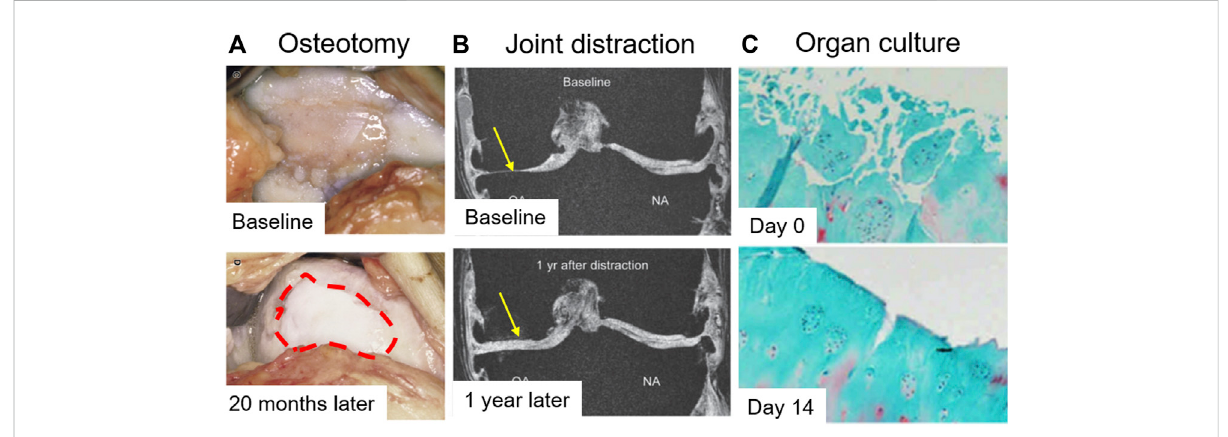
FIGURE 5 Evidence ofcartilagerebuilding in vitro and in vivo . (A) The articularsurfacewasobserved20 months after hightibialosteotomy(HTO).The red dotcircle shows neocartilageformation(Intema etal.,2011). (B) Quantitativemagnetic resonance imaging(MRI) ofthejointwastaken after 1 year of joint distraction (Koshino et al., 2003). (C) OA cartilage was cultured for 14 days. Safranin O-fast green staining was performed (Hoshiyama et al.,